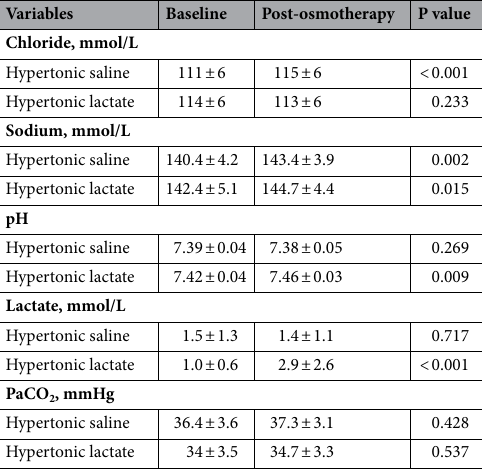
Table 4. Effectiveness of osmotherapy with hypertonic saline vs. hypertonic lactate on arterial blood variables. Data are presented as mean ± standard deviation. P values for comparisons of baseline vs. post osmotic agent treatment (ANOVA for repeated measures). PaCO 2 partial pressure of carbon